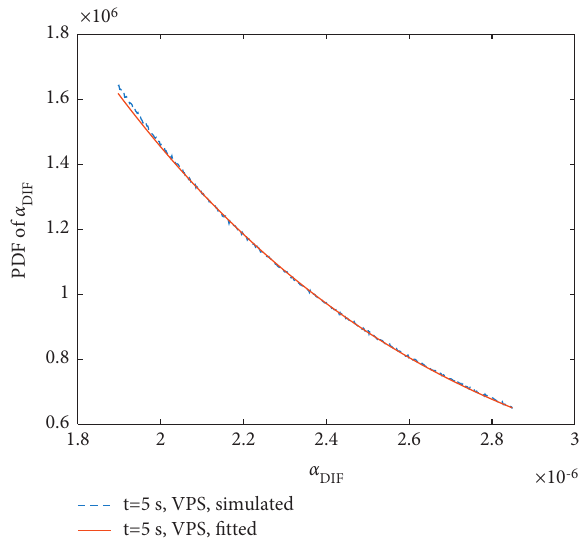
Figure 11: The PDF of α and its fitted function (with t � 5s, VPS, and ϵ � 3 . 57). DIF